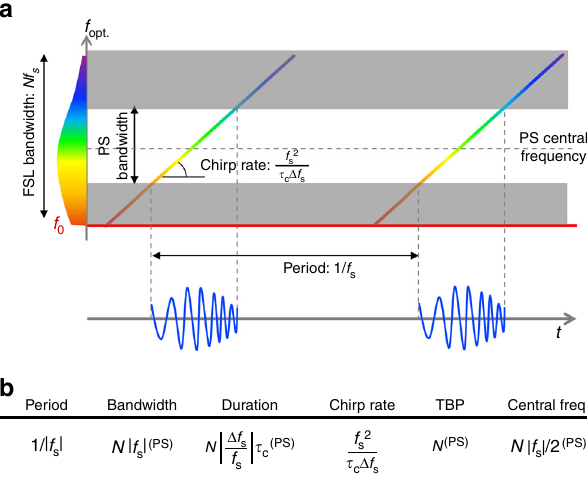
Fig. 3 Control of the RFCWs parameters. a Plot in the time-optical frequency plane, of the optical chirps generated in the FSL (here: f s > 0). Heterodyning the optical chirps with the seed laser (at f 0 ) produces the RF chirps. Both the central frequency and bandwidth of the chirps can be controlled by the pulse shaper (PS) at the output of the FSL. Here, the PS is used as a bandpass fi lter, and blocks the optical frequencies contained in the gray areas. b Summary of the RF chirps ’ parameters generated in the FSL as a function of the main design speci fi cations of the FSL (see Fig. 2), i.e., round-trip propagation time in the FSL loop ( τ c ), in-cavity